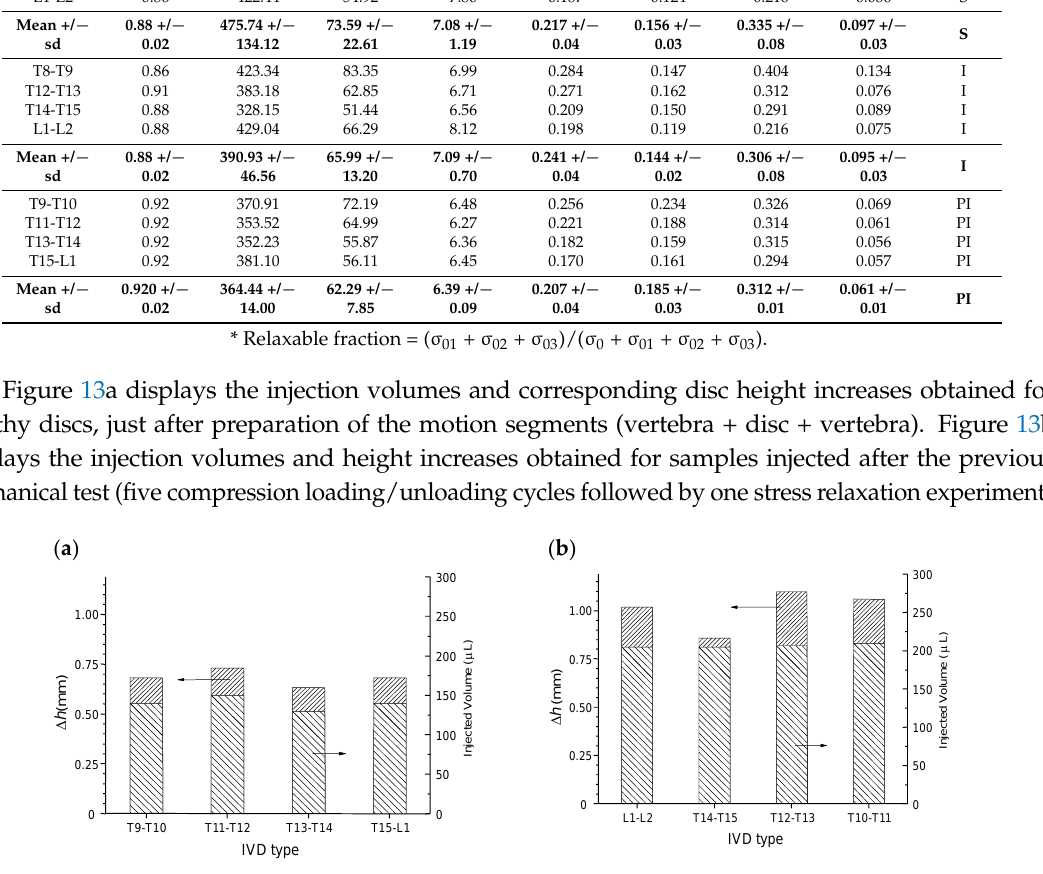
Figure 13. Increase of IVD height after intradiscal injection of cellulose nanofiber-filled chitosan CNF/CHI formulation (2% ( w / w ) CHI/ 0.3% ( w / w ) CNFs). ( a ) Healthy discs (S); ( b ) discs injected (I) after five compression loading/unloading cycles up to 400 N load and a stress relaxation experiment performed for 15 min (see Section 2. Materials and